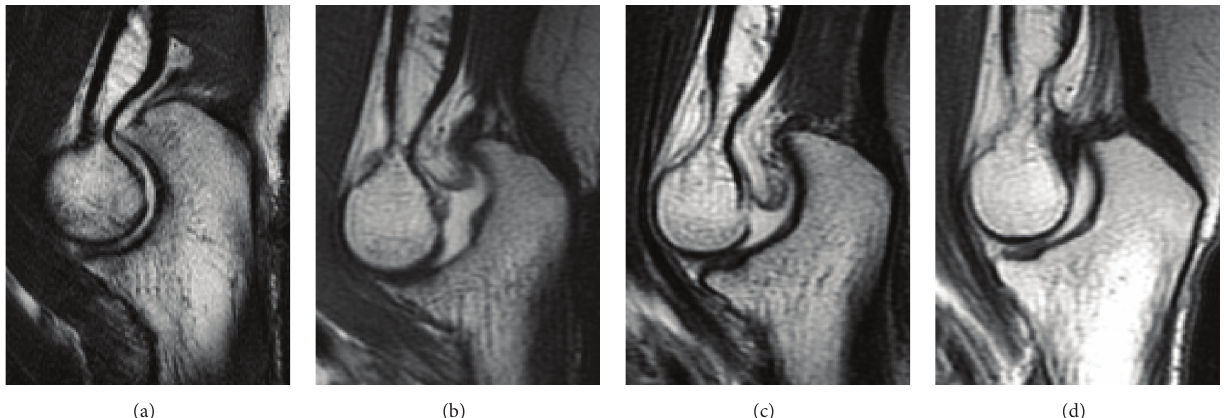
Figure 1: Magnetic resonance images of the elbow. (a) Sagittal T2-weighted image of a normal elbow. Preoperative sagittal T2-weighted images of the (b) right and (c) left side in the present case show a hypertrophied posterior fat pad interposed between the olecranon and olecranon fossa in both elbows. The posterior fat pad in the left elbow is located more inferiorly than that in the right elbow. Postoperative sagittal T2-weighted image of the (d) left elbow shows no posterior fat pad interposed between the olecranon and olecranon fossa.